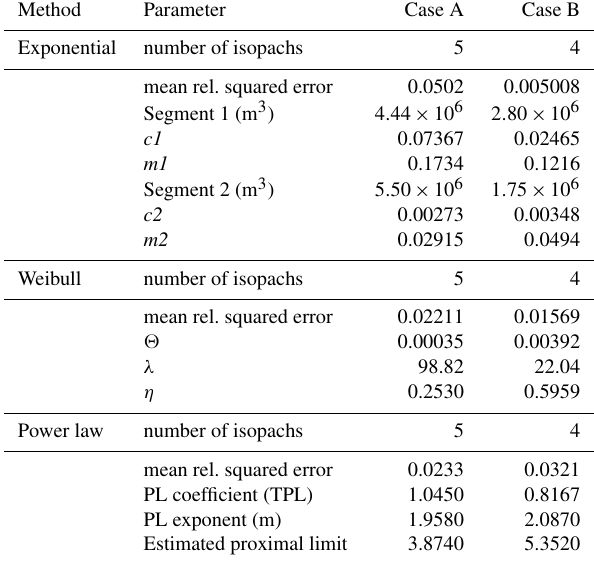
adjunction of the volumes calculated for segments 1